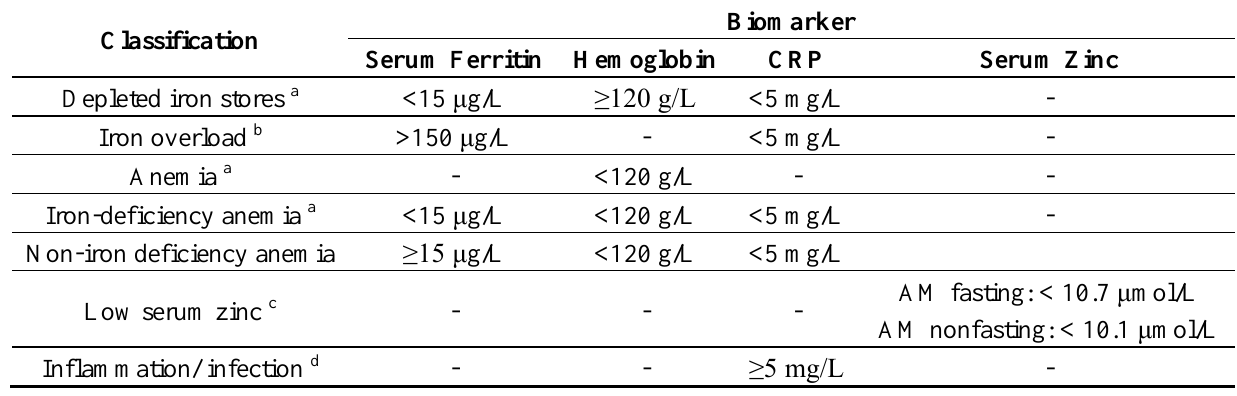
Table 1. Reference values used to interpret biomarkers of iron and zinc